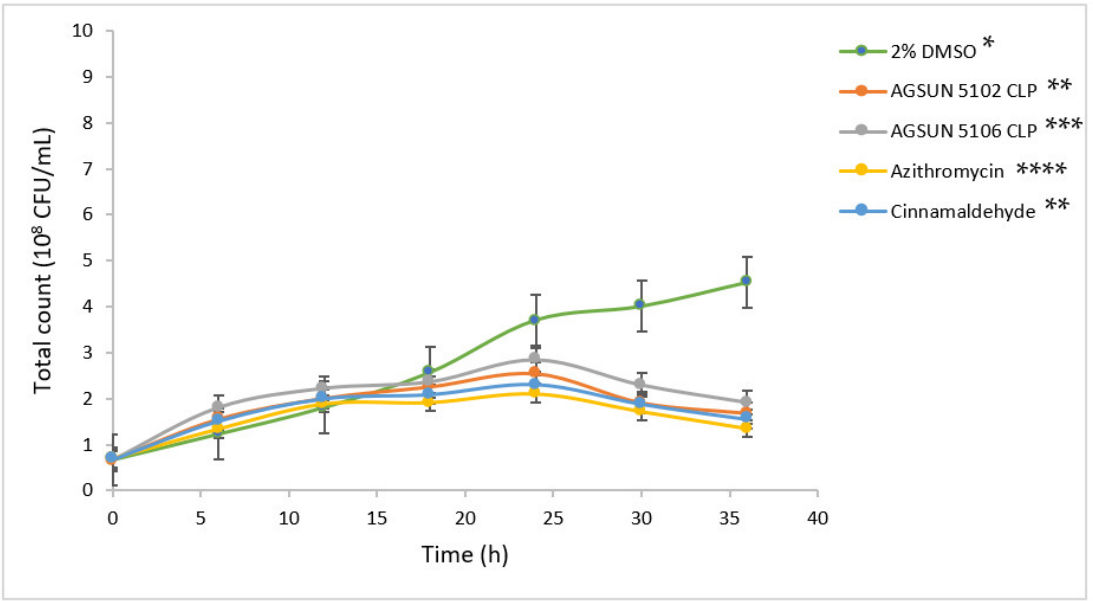
Figure 1. Growth curves of P. aeruginosa supplemented with different treatments at 37 °C for 36 h. The growth profiles are statistical difference at p -value ≤ 0.05 with *, **, *** and **** denoting significant differences between the treatments.